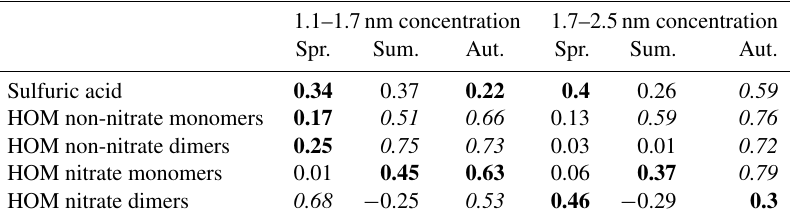
Table 4. Logarithmic Pearson correlations of known precursor vapors with particle concentrations for spring (Spr.), summer (Sum.), and autumn (Aut.) seasons during event times between 10:00 and 14:00LT. Winter did not have enough available event points for correlation analysis. Statistically significant values ( p < 0 . 05) are bolded and values higher than 0.5 are highlighted in